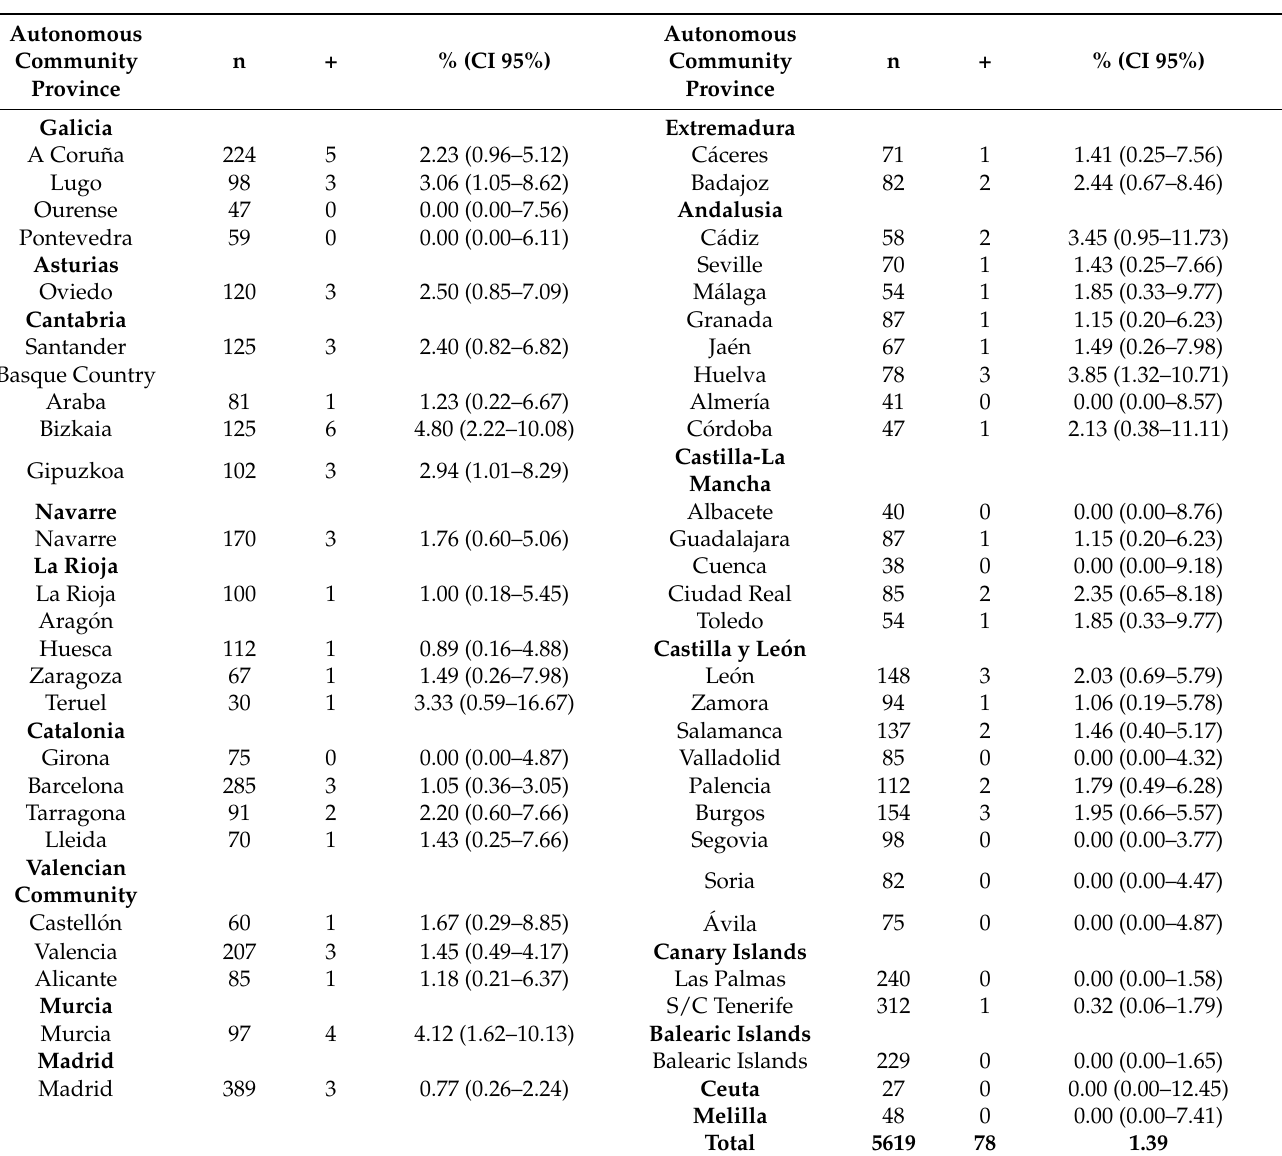
Table 2. Prevalence of A. vasorum in dogs in Spain by province and autonomous cities (Ceuta and Melilla). Abbreviations : n, number of dogs sampled; +, number of positive dogs; %, percentage of positive dogs (confidence interval